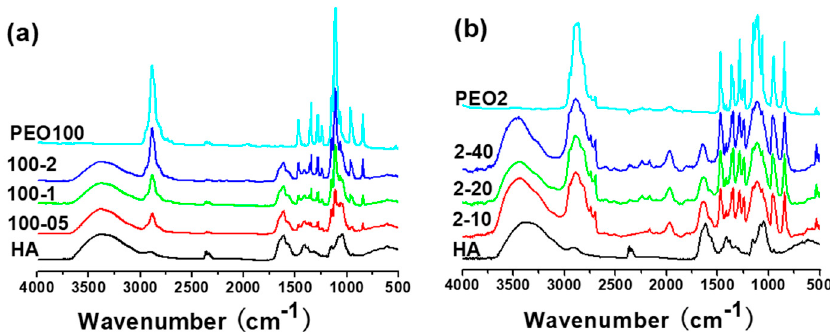
Figure 7. Fourier transform infrared spectroscopy (FT-IR) spectra of the HA / PEO blended electrospun membranes and HA and PEO casting films. ( a ) HA / PEO-100 blended membranes and PEO-100 casting film; and ( b ) HA / PEO-2 blended films and PEO-2 casting film.